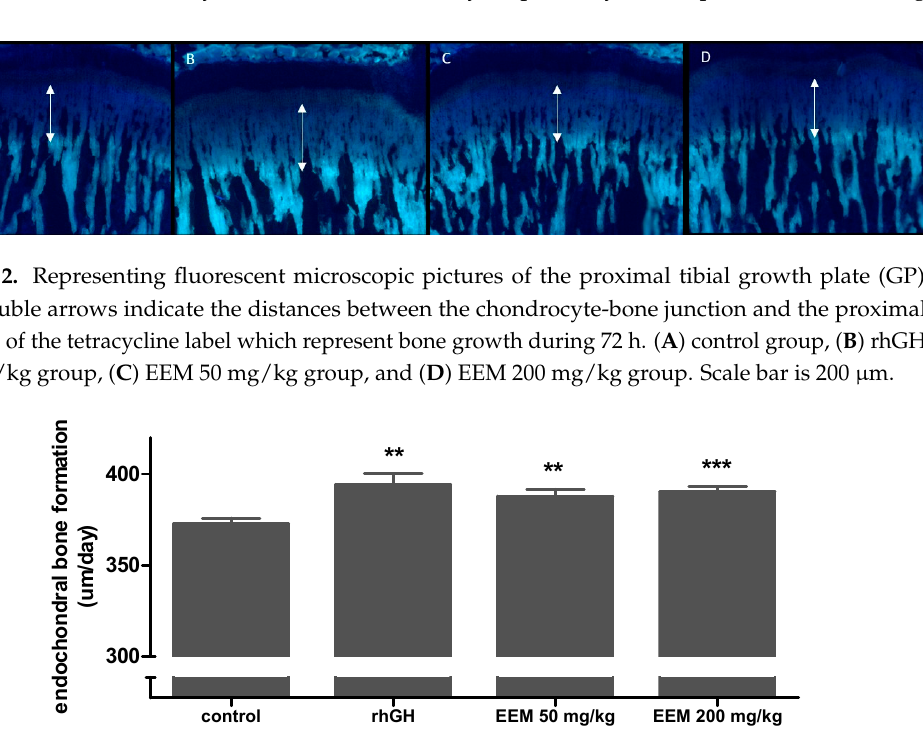
Figure 3. Effects of EEM on endochondral bone formation in Growth Plate (GP) of proximal tibial. Each value is the mean ± SEM. The number of rats is 53–55 per group; ** p < 0.01 and *** p < 0.001 vs. control by one-way ANOVA, Dunnett’s test.